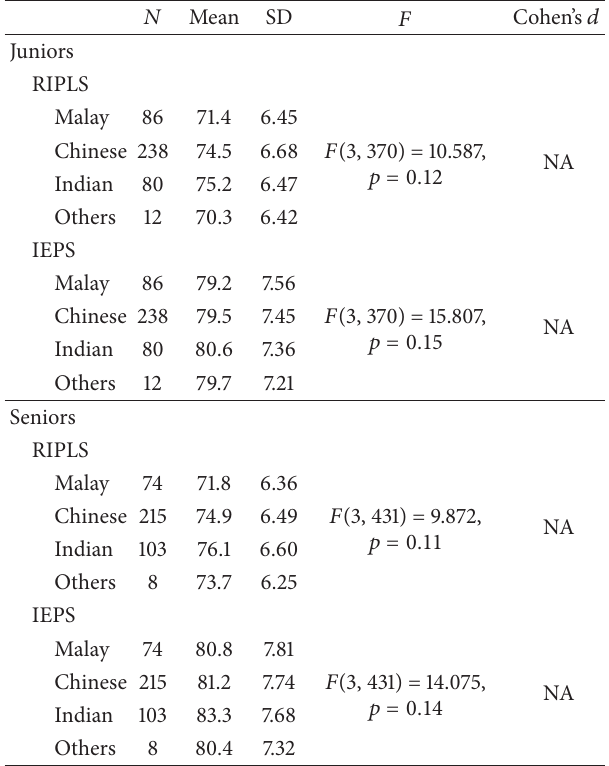
Table 4: Mean scores and significant differences of the RIPLS and IEPS by student ethnicity.